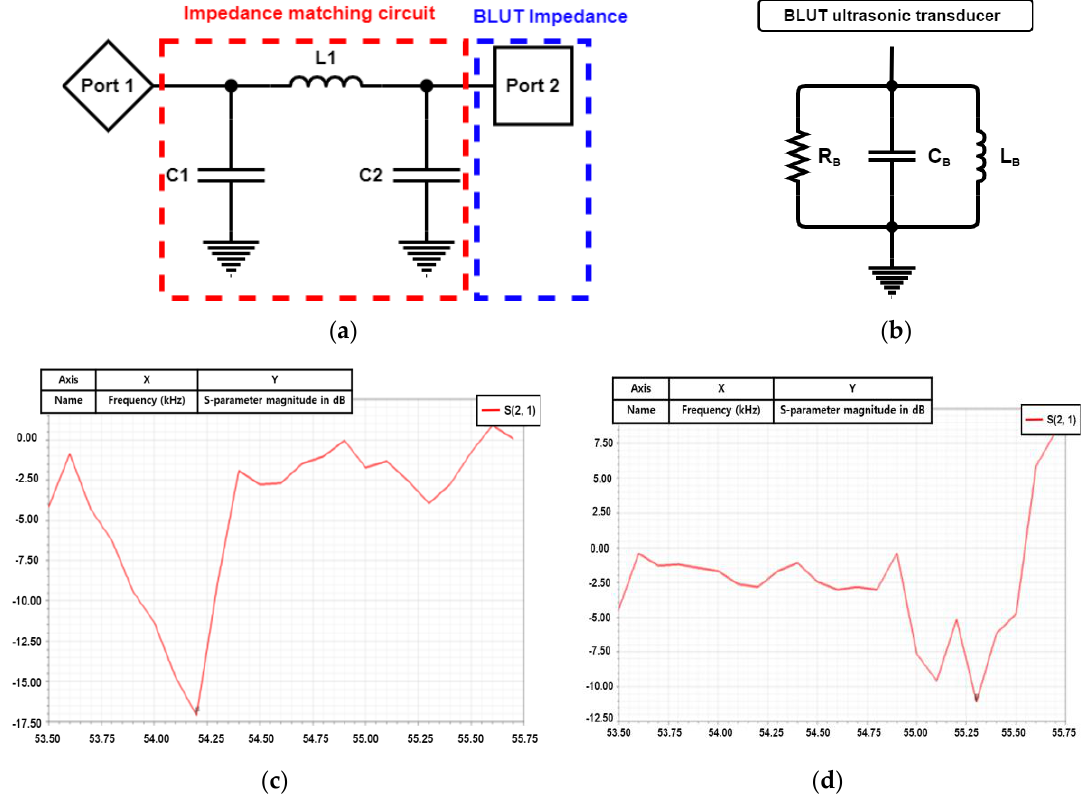
Figure 14. ( a ) Simulation model of the impedance matching circuit with the BLUT. ( b ) Equivalent circuit model of BLUT. S-parameter values vs. frequency ( c ) without a matching circuit and ( d ) with matching circuit.